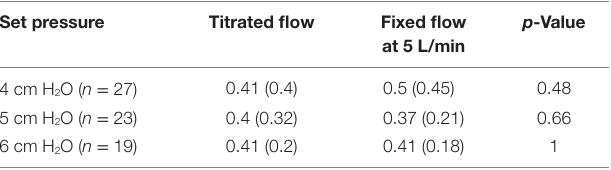
TaBle 2 | noise (maximum–minimum delivered pressures) at different set cPaP pressures.